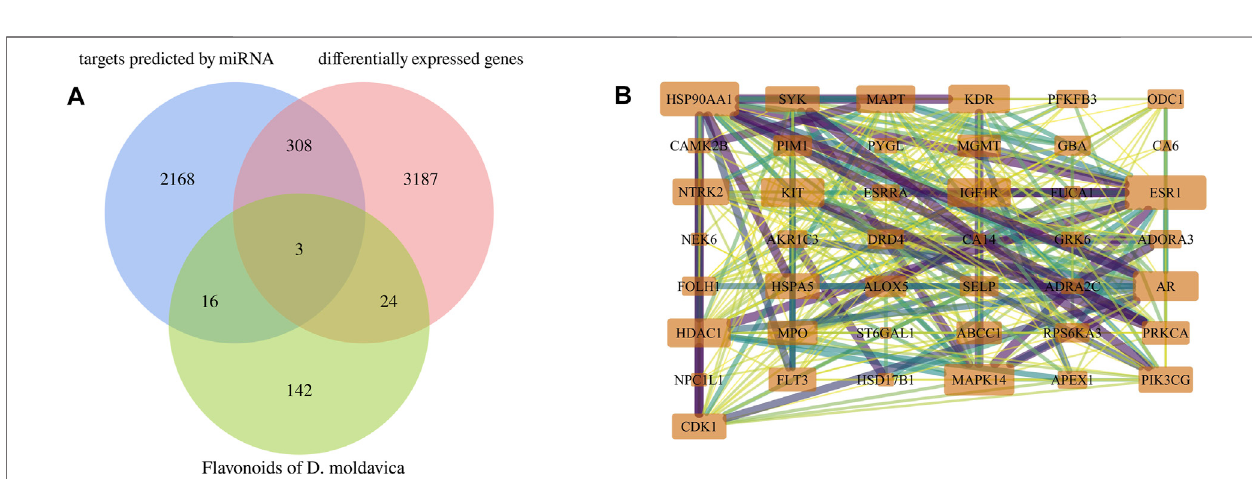
FIGURE7| Identi fi cationofkeytargetsforTFDM. (A) IntersectionVenndiagramofpotentialtargetsofVaDandtargetsofTFDM. (B) Forty-three effectivetargetsof TFDM for the treatment of VaD overlapped in the established potential VaD target library.